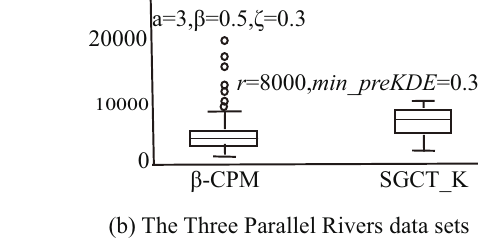
Figure 6. The distance distributions of neighbor pairs in the given data sets with β -CPM in comparison with SGCT_K. ( a ) The distances are lower and more differentiated with β -CPM than with SGCT_K in the Synthetic data set, ( b ) and so are they in the Three Parallel Rivers data